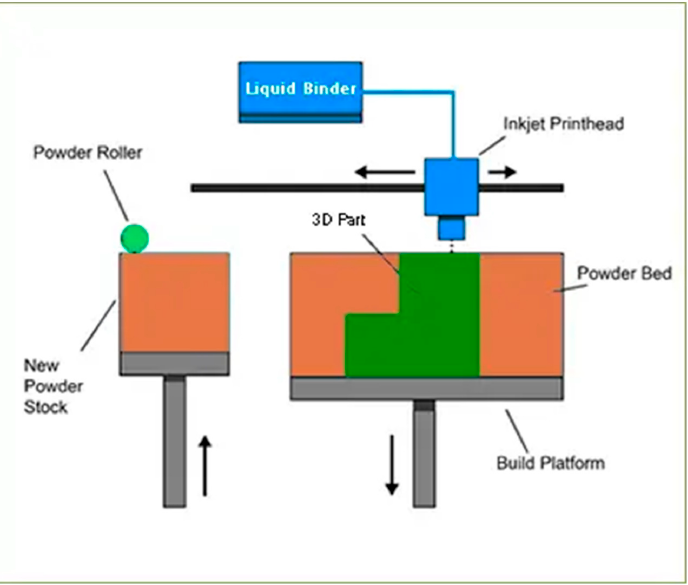
Figure 4. Simplified schematic presentation of the liquid binding process. Picture taken from an article by Nikhil [29].